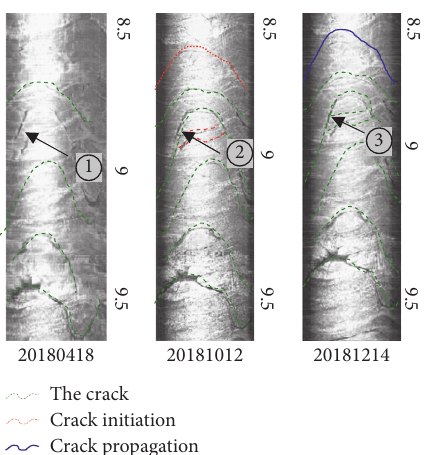
Figure 12: Continuous observation of cracking process.